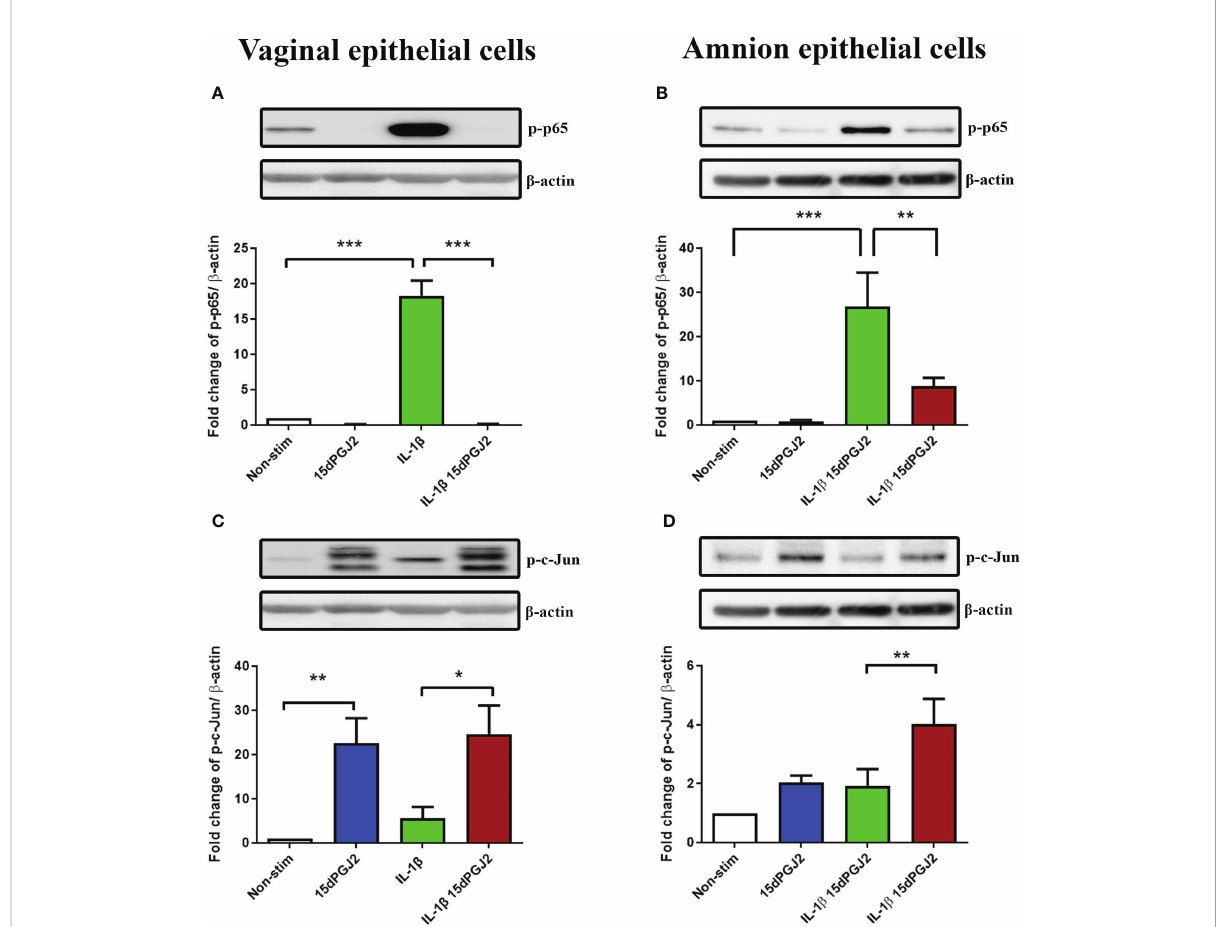
FIGURE 6 Effect of 15dPGJ2 on NF- k B and AP-1 in vaginal and amnion epithelial cells. Vaginal (VEC) and amnion epithelial cells (AECs) were pre-incubated with 32 m M of 15dPGJ2 for 2 hours then stimulated with 1ng/ml of IL-1 b . Whole cell lysate was used to determine serine 536-phosphorylated p65 (Ser536-p-p65) as a marker of NF- k B activation and serine 73-phosphorylated c-Jun (Ser73-p-c-Jun) as a marker of AP-1 via western immunoblotting. A representative blot was shown above each graph with b -actin as a loading control. Pre-incubation with 15dPGJ2 signi fi cantly inhibited IL-1 b stimulated NF- k B in VECs ( p < 0.001) (A) and AECs ( p < 0.01) (B) . AP-1 however signi fi cantly increased after incubation with 15dPGJ2 alone as well as with 15dPGJ2 and IL-1 b in VECs ( p < 0.01) (C) and also in 15dPGJ2 and IL-1 b treated AECs ( p <0.01) (D) . * p < 0.05, ** p < 0.01, *** p < 0.001. n = 3-6. Data are presented as mean ±